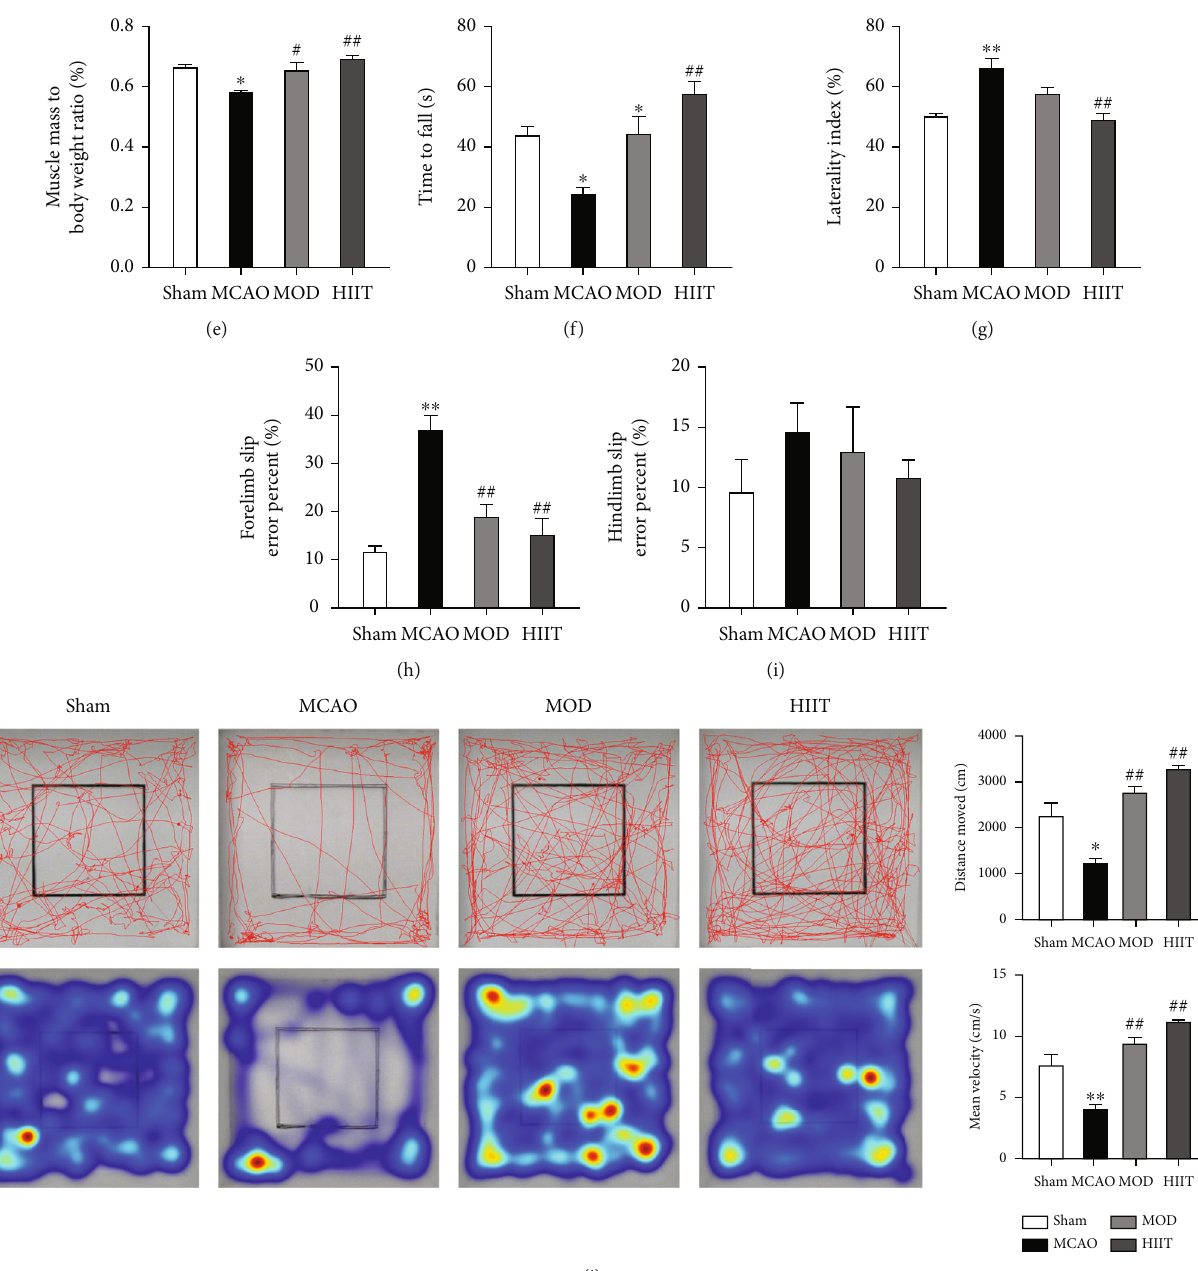
Figure 2: Amelioration of muscle wasting and motor dysfunction after exercise protocols. (a) Changes in mean values of total body weight and weight growth rate (data are expressed as the change with respect to day 0) in each group. (b) The grip strength (g) of bilateral forelimbs measured using a digital force gauge in each group ( n = 5 ). (c) The ratio of grip strength and body weight in bilateral forelimbs in each group ( n = 5 ). (d) Muscle mass (mg) of paretic gastrocnemius in each group ( n = 6 ). (e) The ratio of paretic gastrocnemius mass and body weight in all groups ( n = 6 ). (f) Time course of the latency to fall o ff the rotarod in the rotarod test in each group ( n = 6 ). (g) The percentage of laterality in the cylinder test in each group ( n = 6 ). (h, i) The percent of forelimb slips and hindlimb slips in the ladder rung walking test in each group ( n = 6 ). (j) Motion trajectory and trajectory endpoint heat map of each mouse in the open fi eld test (left); the total distance of motion trajectory (cm) and mean velocity (cm/s) of each mouse (right) ( n = 6 ). Values are expressed as the mean ± SEM of the mean. ∗ P < 0 : 05 and ∗∗ P < 0 : 01 compared with the sham group; # P < 0 : 05 and ## P < 0 : 01 compared with the MCAO group; + P < 0 : 05 and ++ P < 0 : 01 compared with the MOD group as determined by one-way ANOVA (Tukey ’ s multiple comparison test) for the data with normal distribution. The letters for no signi fi cance were not